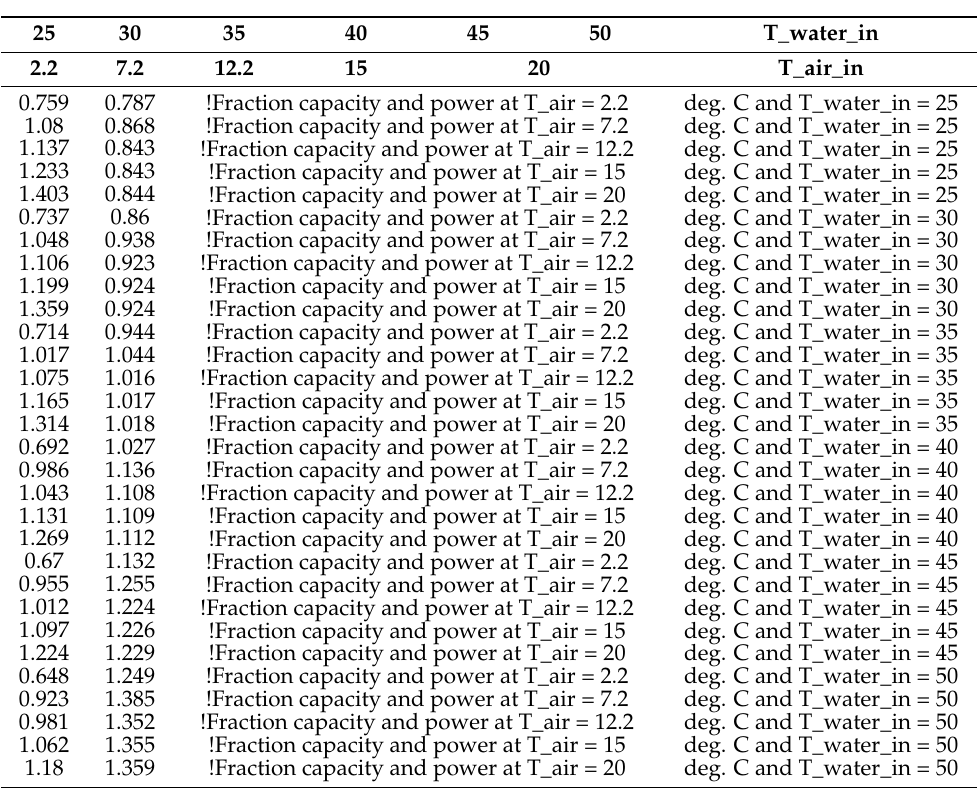
Table A1. Heating performance data of AWHP.